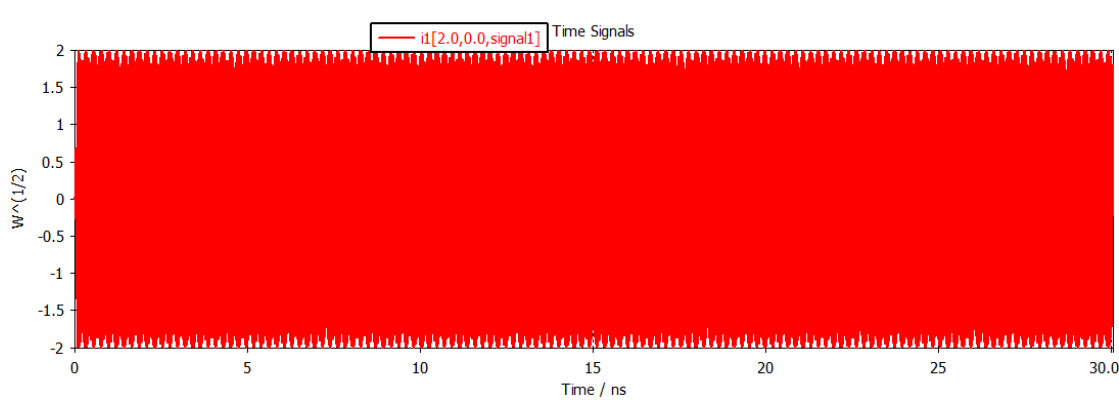
Figure 16. Input port signal of RF section.